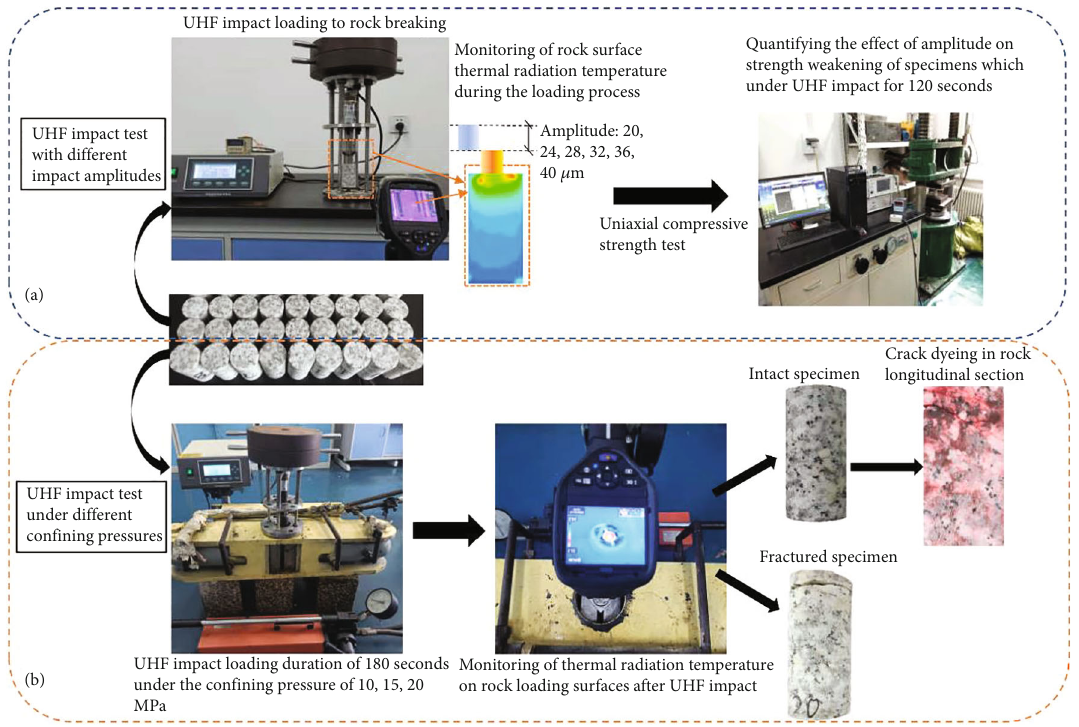
Figure 3: Test procedures: (a) UHF impact test with di ff erent impact amplitudes; (b) UHF impact test under di ff erent con fi ning